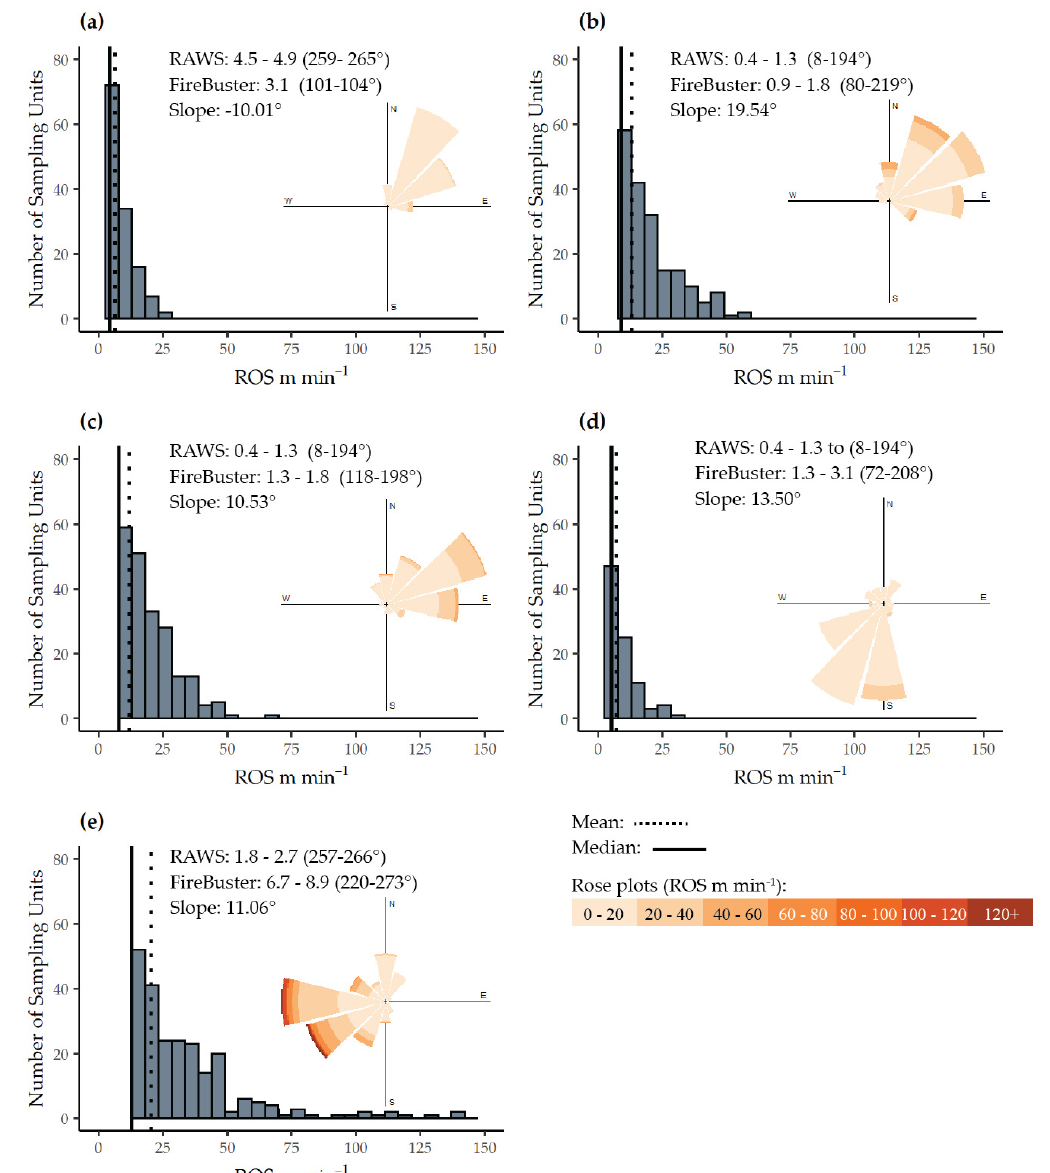
Figure 4. Fire spread rate sample frequency histograms and rose plots of sample spread frequency by rate of spread with Remote Access Weather Station (RAWS) and FireBuster wind speeds (m s − 1 ) and wind direction (deg) ranges during airborne thermal infrared imaging. Generalized slope trend for sequences are also included. ( a ) Detwiler. ( b ) Thomas 1. ( c ) Thomas 2. ( d ) Thomas 3. ( e ) Thomas 4.